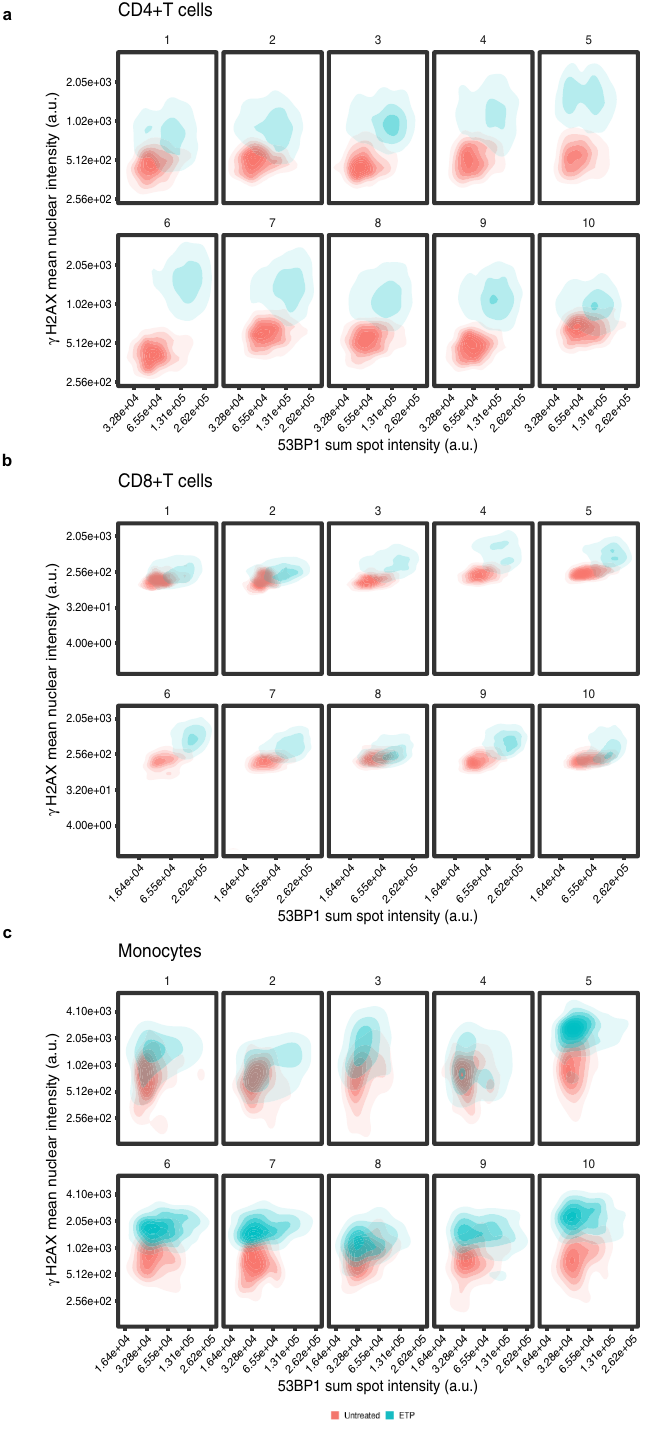
Figure 5. Batch processing of human primary immune cells for analysis of 53BP1 spot intensity and γ-H2AX nuclear intensity. CD4 + T, CD8 + T, and monocytes of 10 different donors were processed simultaneously, left untreated or treated with 30 µM ETP for 1.5 h and imaged in high-throughput format. 53BP1 sum spot intensity vs. γ-H2AX mean nuclear intensity were blotted for each donor for ( a ) CD4 + T cells, ( b ) CD8 + T cells ( c ) monocytes. N = 663–5693 cells per